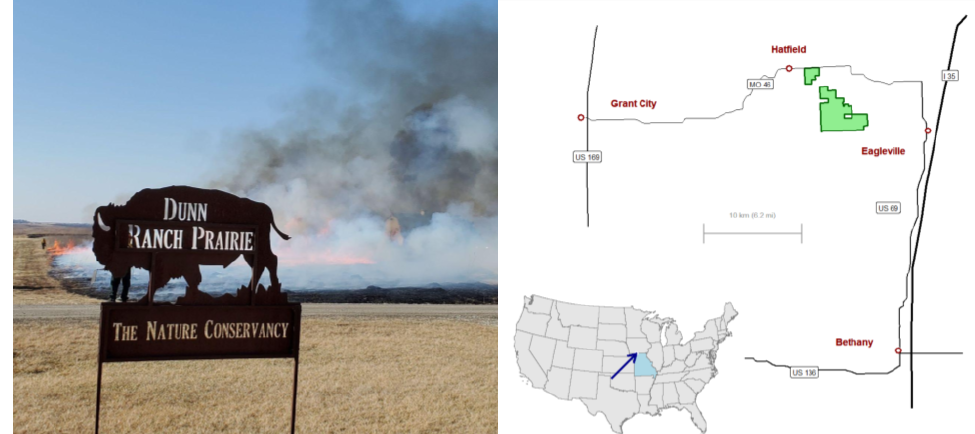
Figure 4. The Nature Conservancy’s Dunn Ranch Prairie, in northern Missouri, USA, hosted the 2022 hands-on workshop in fire science methods. In the large map on right, the Dunn Ranch is highlighted in green and indicated on the inset by the blue